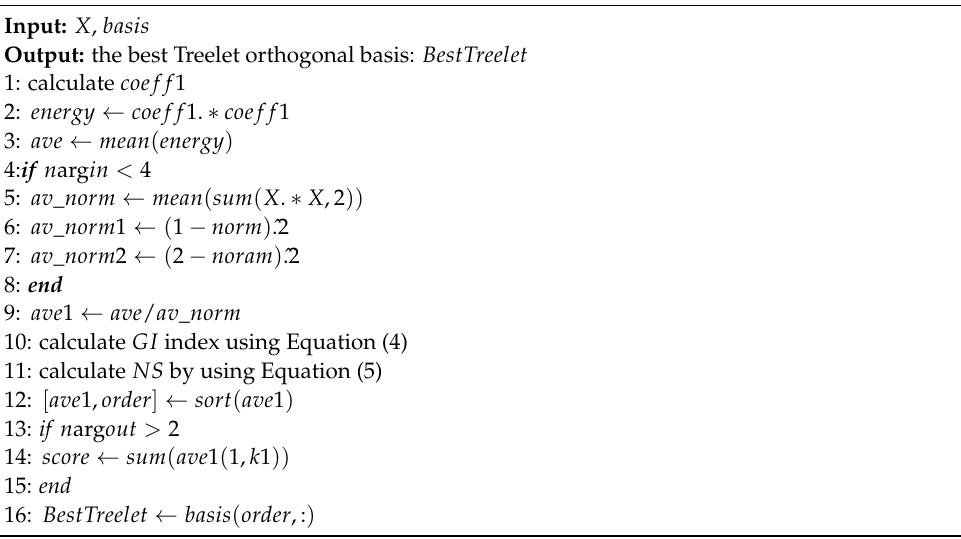
Figure 4. The flow chart of SCBA. Algorithm 2 optimal basis algorithm with greedy scoring